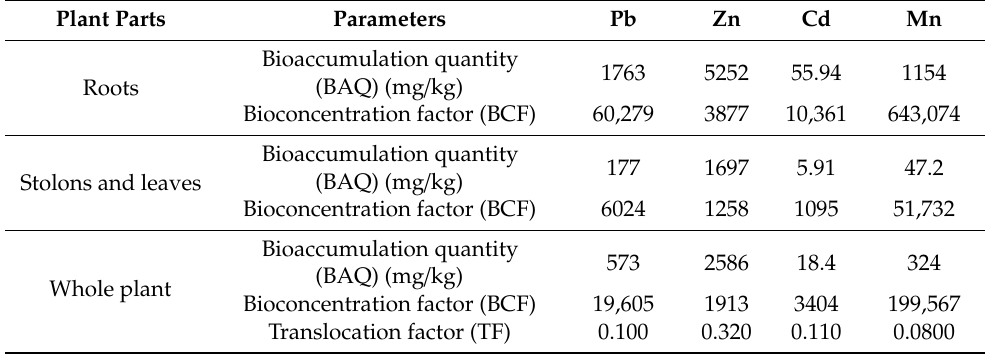
Table 5. Accumulation characteristics of Pb, Zn, Cd, and Mn in the distinct Eichhornia crassipes plant organs.